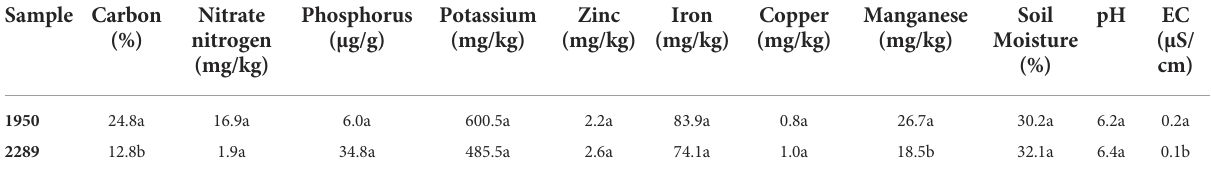
nifH + gene (Table 1 and Figure 3). Most of this study ’ s isolates that tested positive for nitrogen fi xation belonged to Pseudomonas.